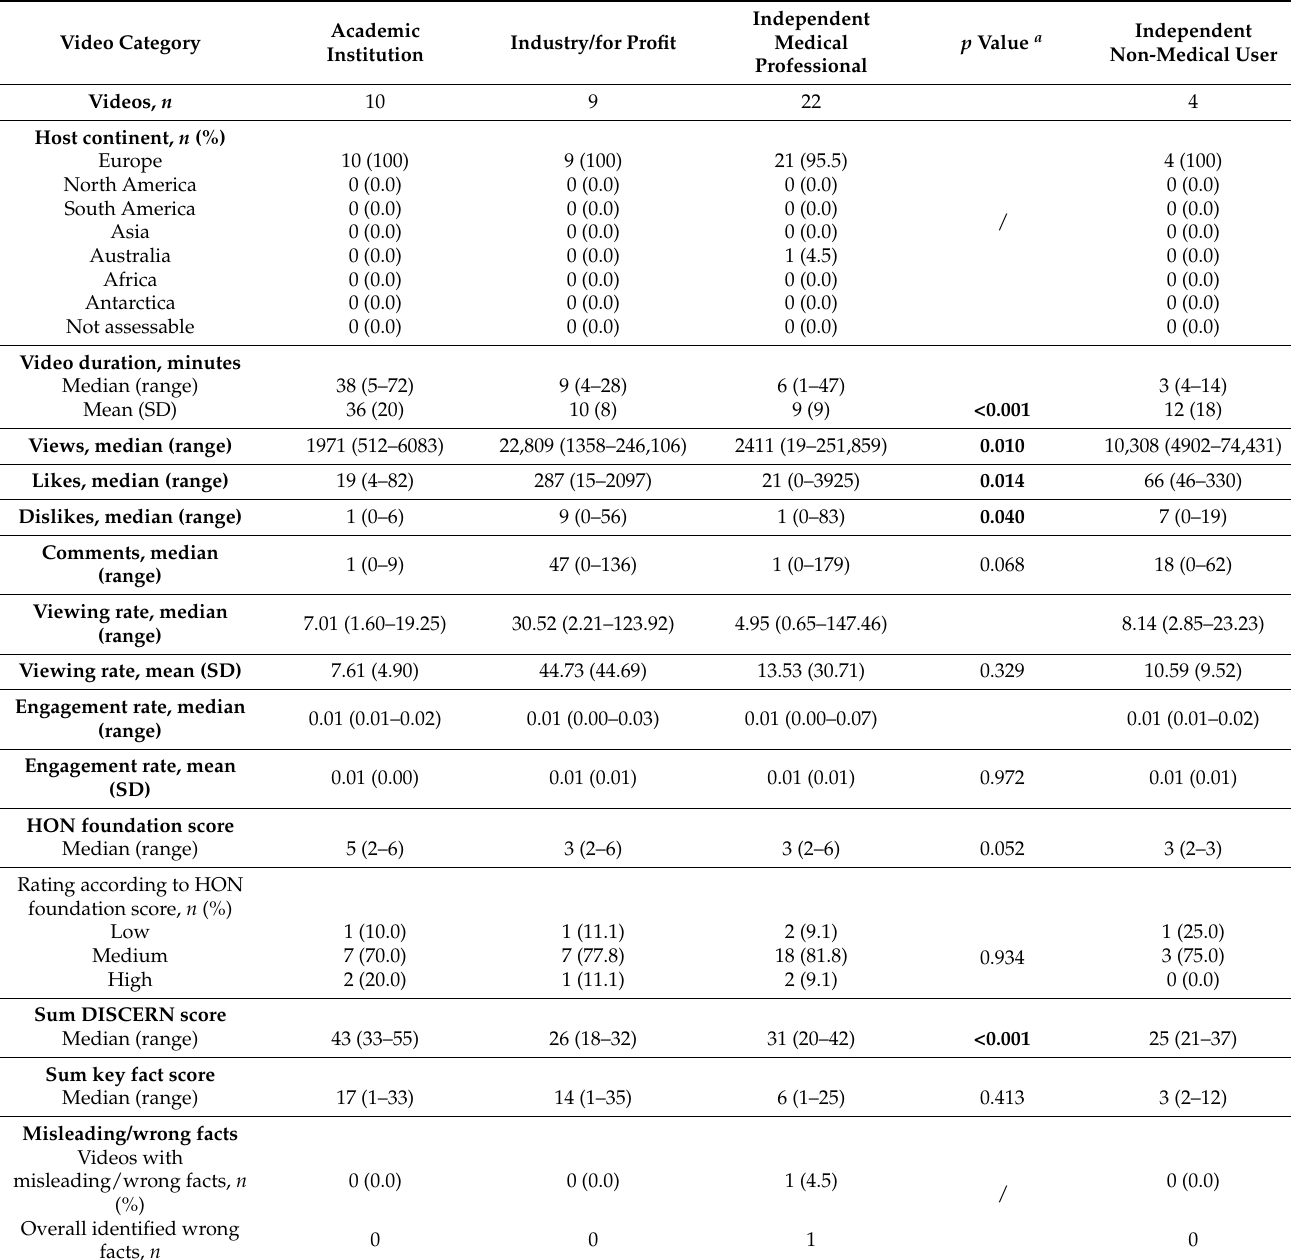
Table 3. Characterization of videos by